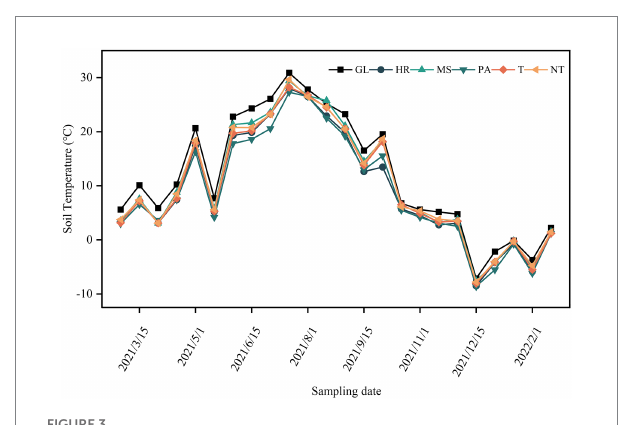
FIGURE 3 Soil temperature under different land use patterns on a semi-arid Loess plateau China.